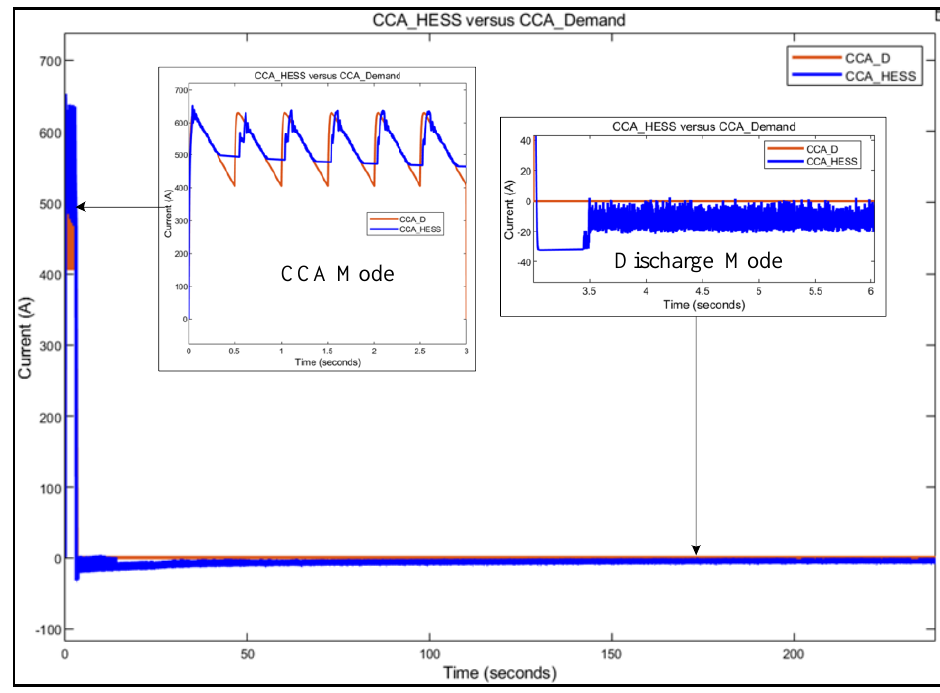
Figure 16. HESS supplying the required CCC for case three (a).